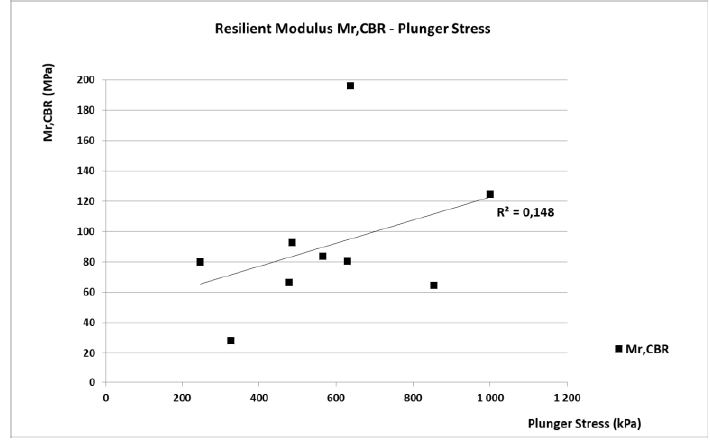
Figure 12. Forests 2020 , 11 , x FOR PEER REVIEW